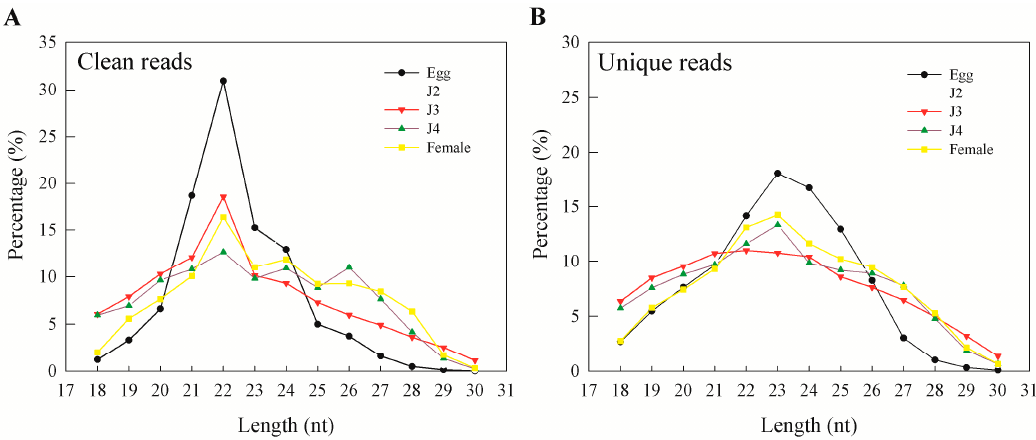
Figure 2. Length distribution of small RNAs at different stages (egg, J2, J3, J4, and female). Frequencies of reads were normalized using DESeq2 to illustrate relative abundances of reads with different lengths under the same scale. ( A ) Clean reads; ( B ) unique reads.